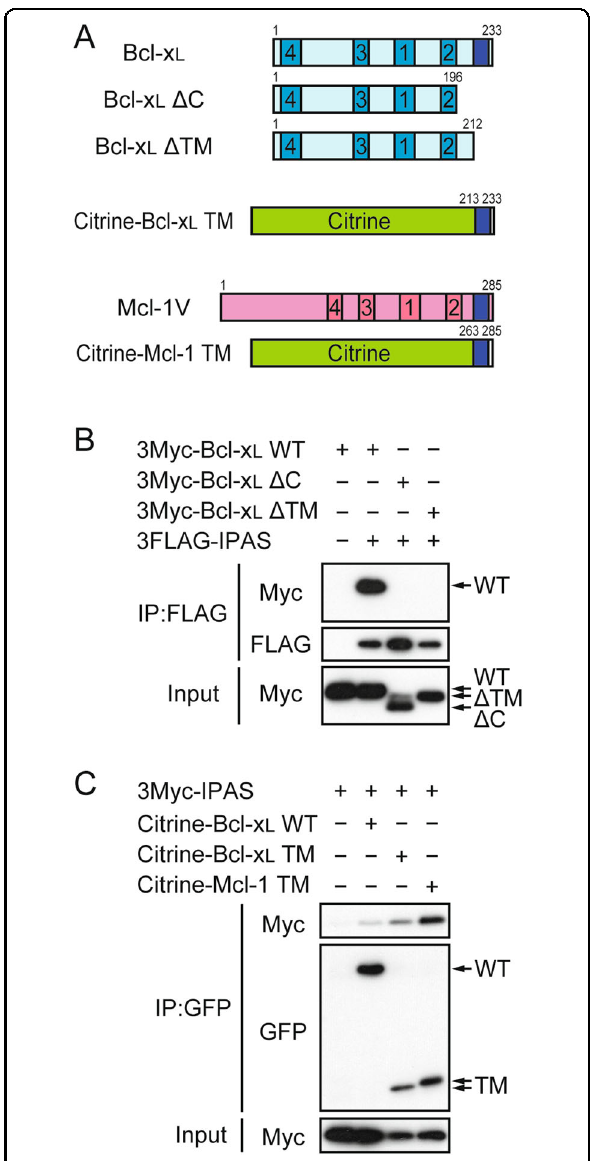
Fig. 1 Binding of IPAS to the TM region of Bcl-x L and Mcl-1. A Schematic representation of the structure of Bcl-x L , Mcl-1V, and their deletion mutants. Bcl-2 homology domains, BH1-4, and TM regions were indicated by numbered and dark blue boxes, respectively. B Lack of binding of tail-less Bcl-x L to IPAS. HEK293T cells were transfected either with pBOS-3FLAG-IPAS and pBOS-3Myc-Bcl-x L WT, pBOS-3FLAG- IPAS, and Δ C or pBOS-3FLAG-IPAS and Δ TM as described in “ Materials and Methods ” section. Twenty-four hours after transfection, cellular proteins were extracted and subjected to immunoprecipitation using the antibody against FLAG, and bound 3Myc-Bcl-x L was analyzed by immunoblotting. C Binding of Bcl-x L and Mcl-1 TM regions to IPAS. 3Myc-IPAS was coexpressed either with Citrine-Bcl-x L TM or Citrine- Mcl-1 TM in HEK293T cells and analyzed as in B